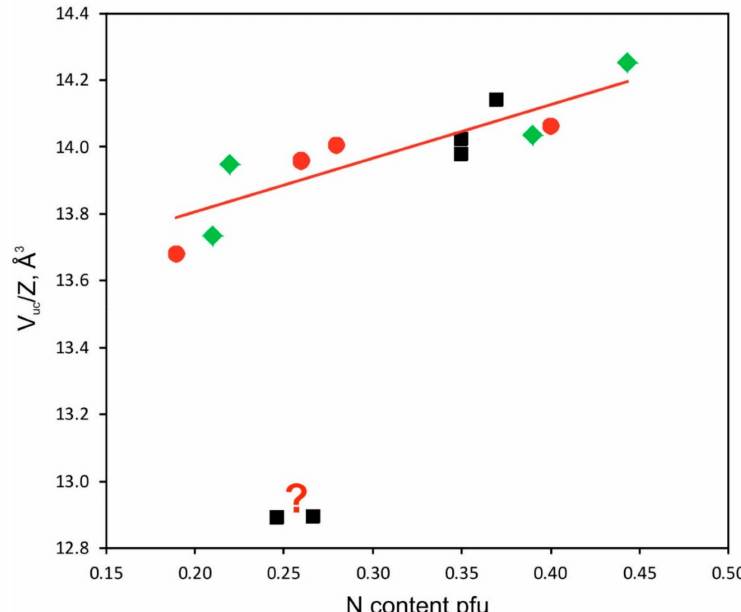
Figure 3. Volume of ε -phase Fe 3 N ≈ 1 vs. number of nitrogen atoms ( x ) per FeN x formula unit. Solid line is linear polynomial obtained by approximation over all points (see text for explanation); circles are new data; squares and rhombs are our previous data from [32] and [21], respectively.